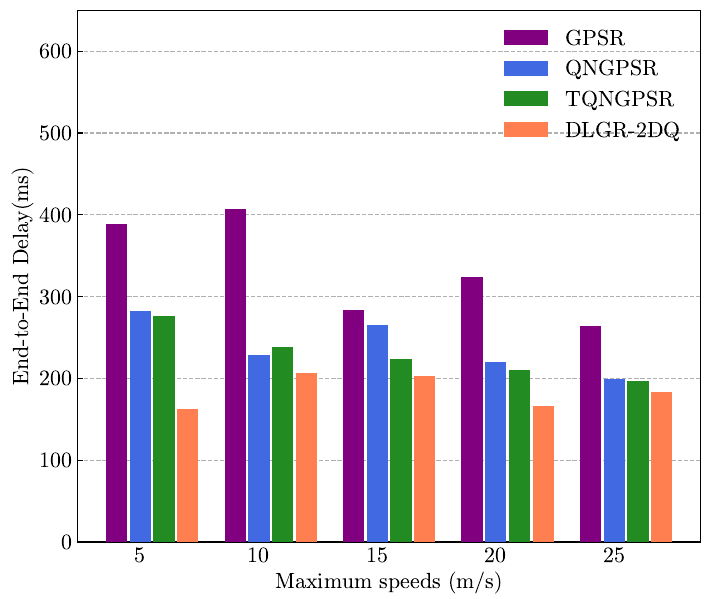
Figure 9. The effects of maximum speed on E2E